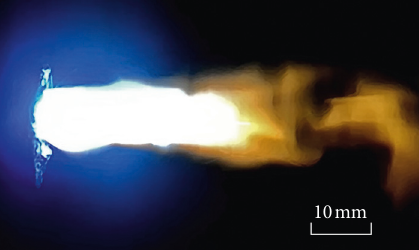
Figure 2: Photos of the O